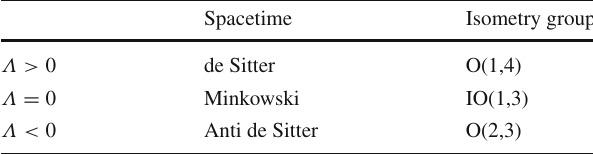
Table 1 Background geometries for vacuum